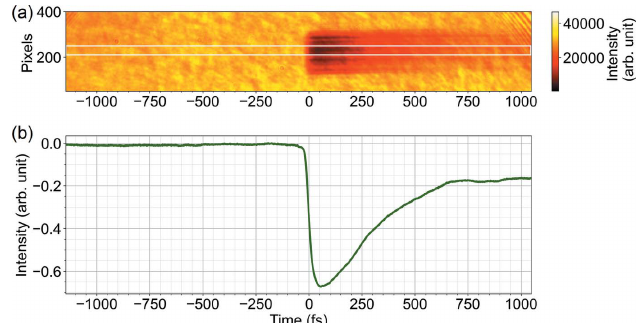
Figure 13 Time zero position determination using spatial encoding at SPB/SFX. ( a ) Laser transmission imaged with the side microscope with 10 (cid:3) magnification. ( b ) Line-out of the selected region highlighted by the white box in ( a